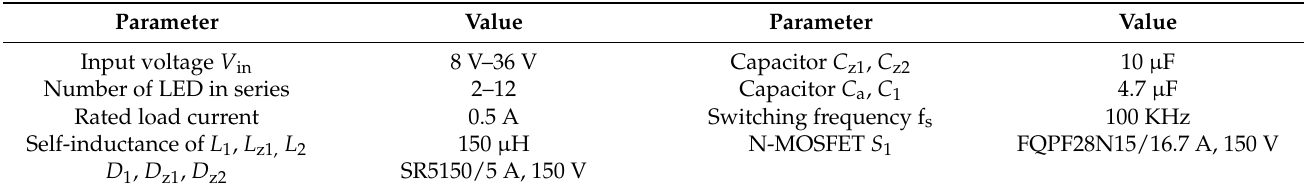
Figure 11. Photograph of the prototype. ( a ) Front view; ( b ) back view. Table 1. Key parameters of the protype.